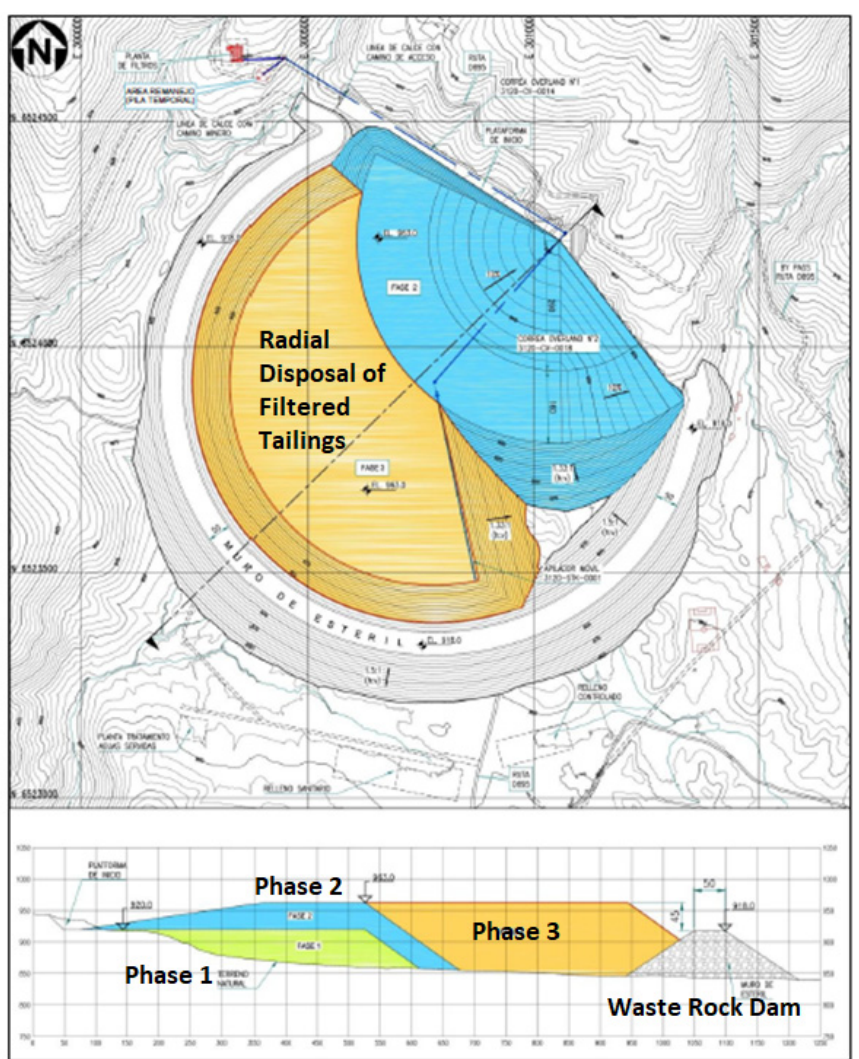
Figure 24. El Espino Mobile Stacker Conveyor with Tripper–Typical Cross Section [51,52,60].